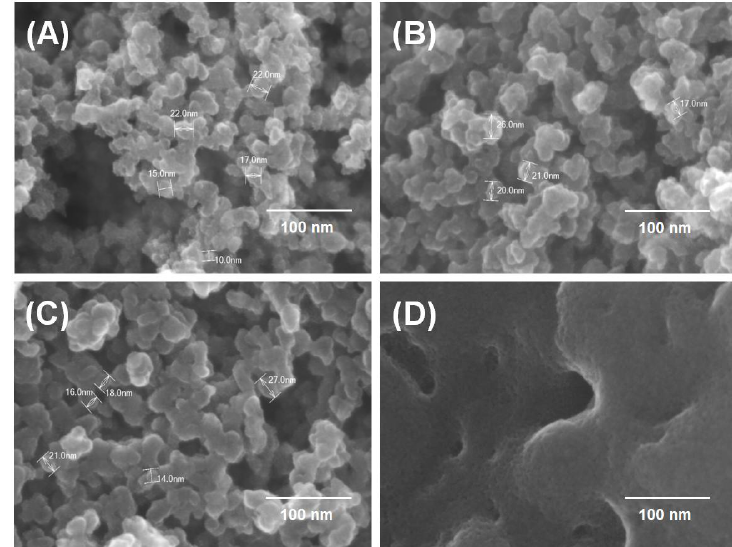
Figure 8. FE-SEM images of the silica-alumina nanoparticle precursor after calcination at different temperatures: ( A ) as prepared; ( B ) 500 °C; ( C ) 800 °C; and ( D ) 950 °C.